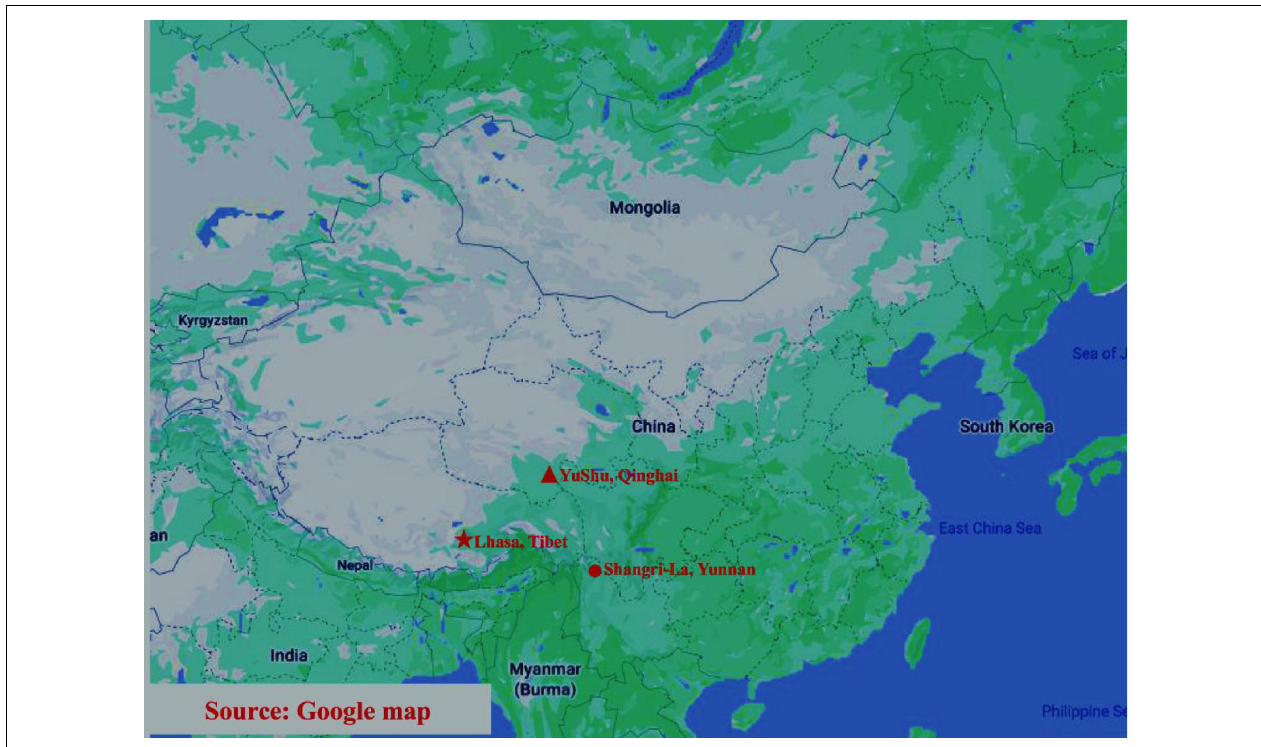
FIGURE 1 | Sampling sites in this research, including Lhasa, Yushu, and Shangri-la. The three sampling locations are represented by different shapes on the map. Triangle: Yushu (Qinghai Province); pentagon: Lhasa (Tibet Autonomous Region); circle: Shangri-La (Yunnan